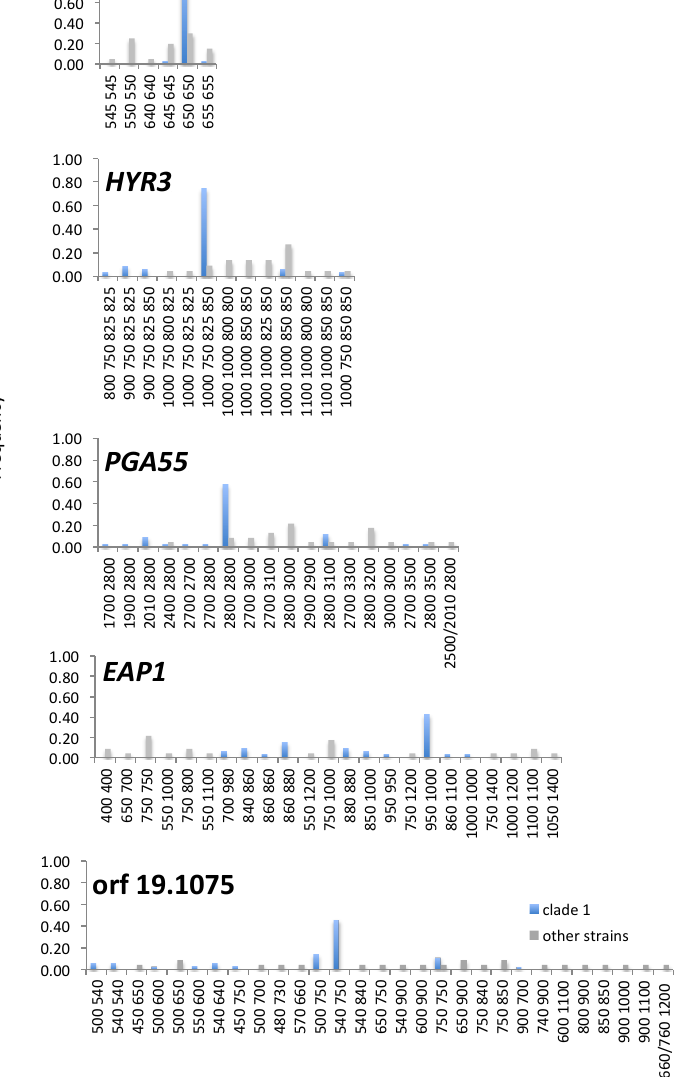
Figure 5. Allele combination frequencies of TR regions with high VARscores in five C. albicans genes in clade 1 strains (blue bars) and other strains (grey bars). Numbers indicate the size of PCR products amplified from the gene. In cases in which only one product size was obtained it was assumed that the strain had two alleles with identical TR region lengths. For HYR 3 allele types include both TRregion A (first pair of numbers) and TR region B (second pair of